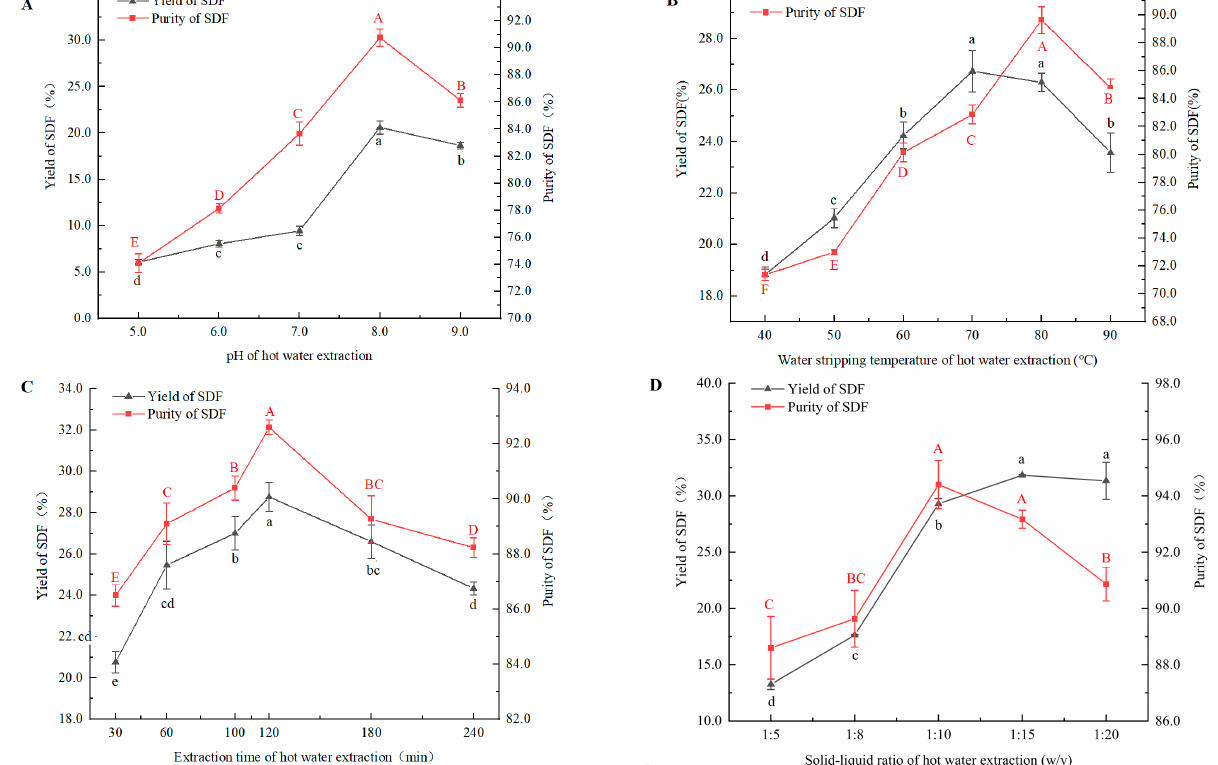
Figure 1. Effects of pH ( A ), water stripping temperature ( B ), extraction time ( C ), and solid-liquid ratio ( D ) on yield and purity of SDF. Different letters on top of the error bar indicate significant ( p < 0.05) differences among samples treated under different conditions.